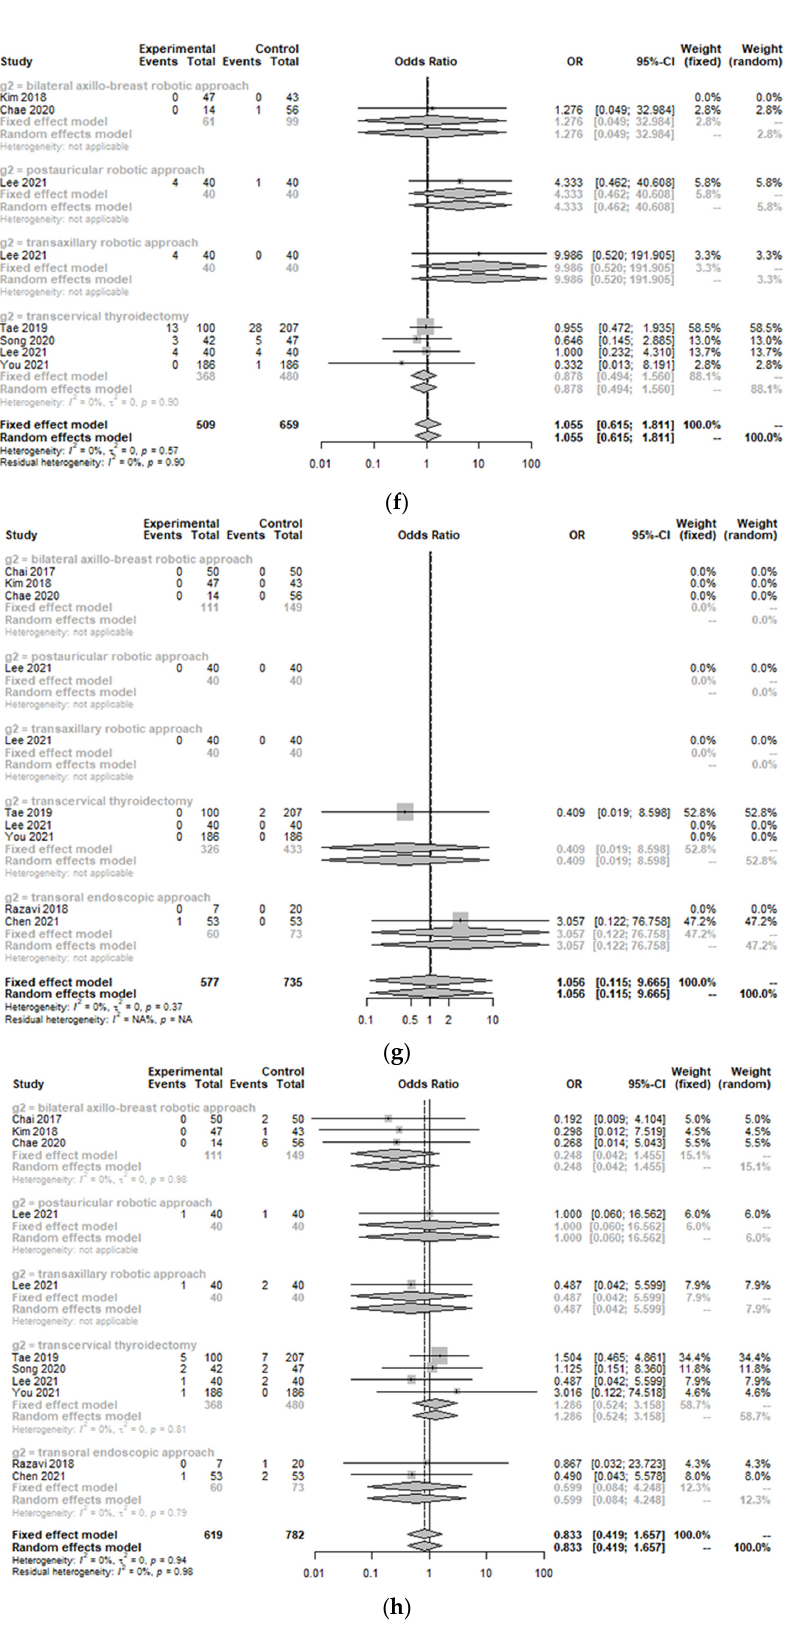
Figure 4. Forest plot for standard mean difference in complications (hematoma ( a ), flap perforation ( b ), permanent hypoparathyroidism ( c ), temporary hypoparathyroidism ( d ), postoperative infection ( e ), seroma ( f ), permanent vocal cord palsy ( g ), and temporary vocal cord palsy ( h )) (total: number of participants per